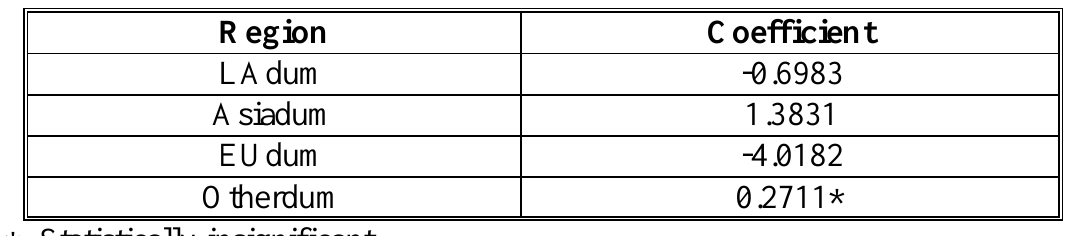
Capital account openness regression results with regional